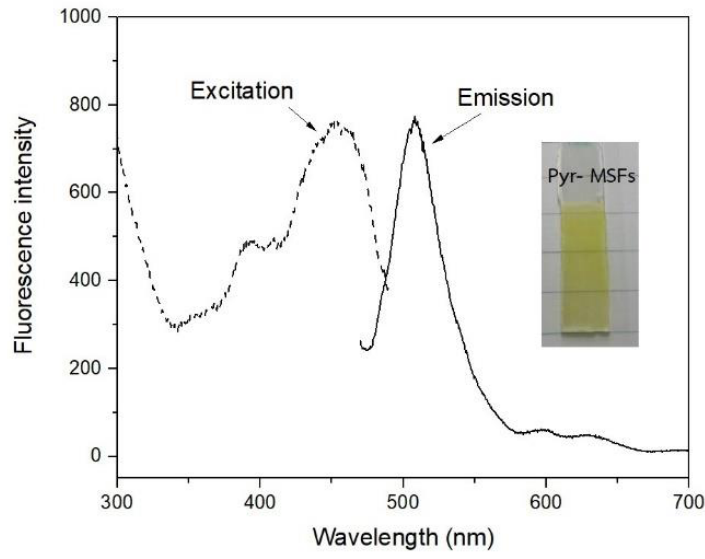
3 solution containing 5 mM Ru(NH 3 ) 63+ ( a ) and 5 mM Fe(CN) 63− ( b ) at scan rate of 0 . 1 Vs –1 .